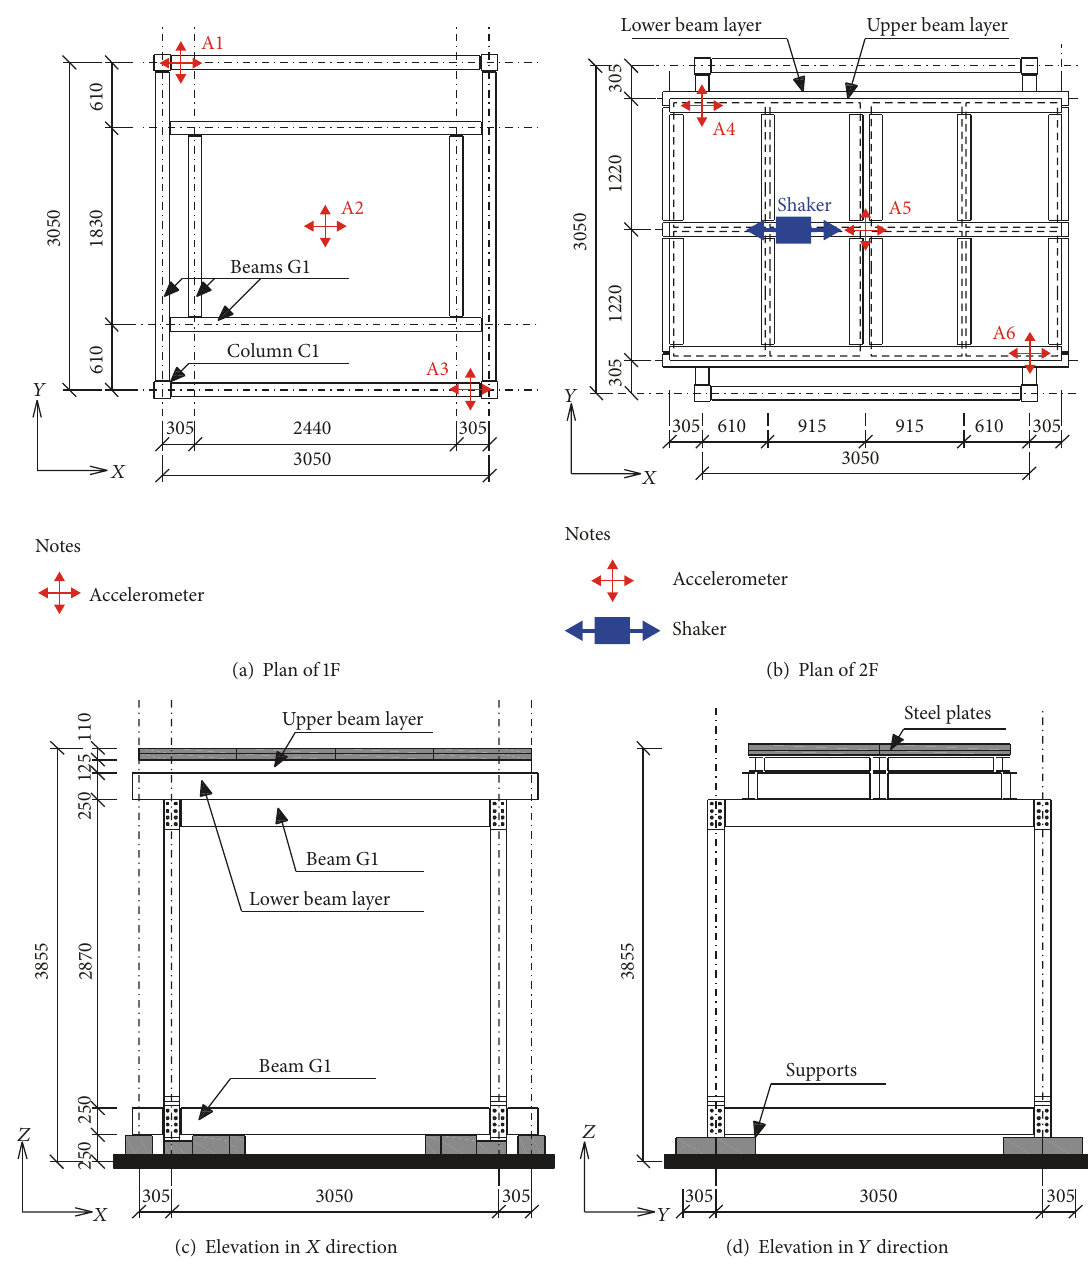
Figure 1: Plans and elevations of steel frame (unit: mm).